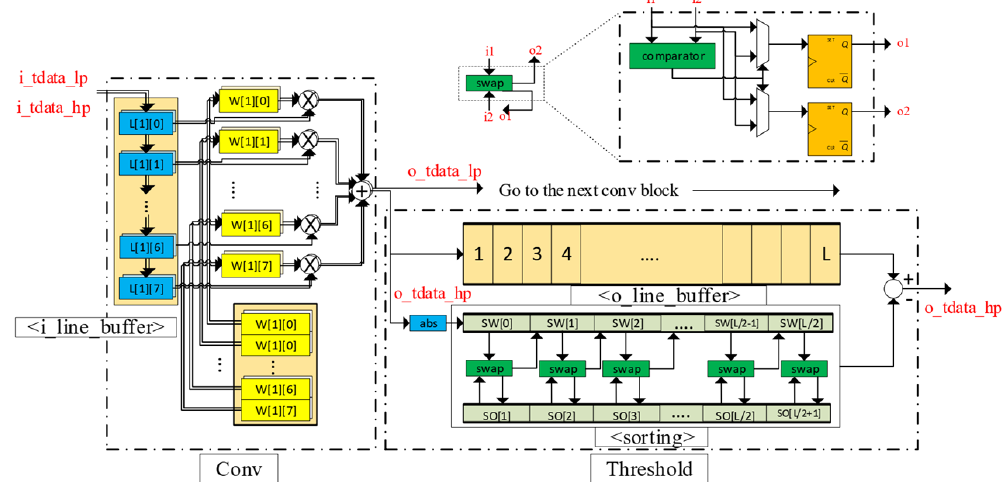
Figure 11. Fine-grain view of the two fundamental blocks: Conv and